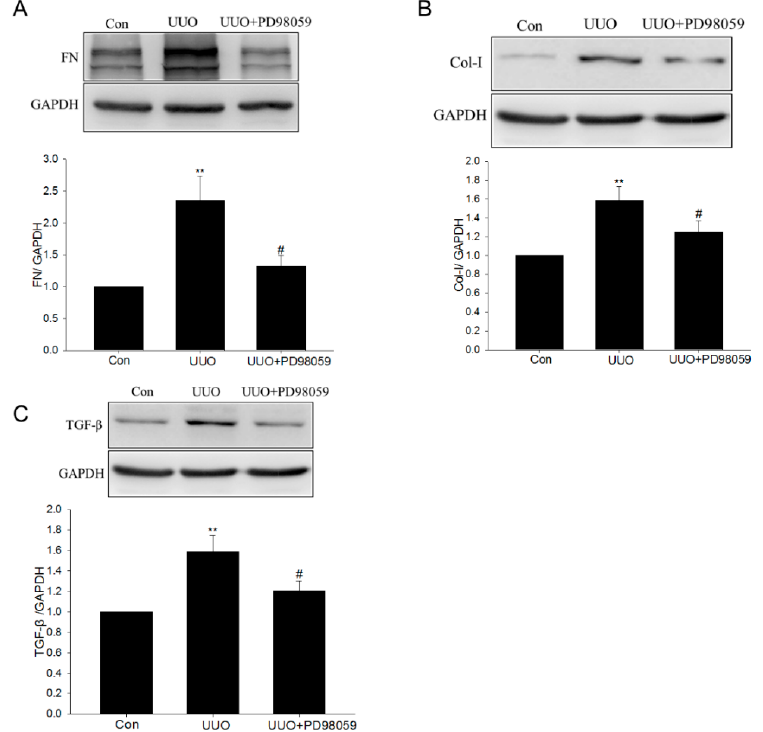
Figure 5. The effect of PD98059 on unilateral ureteral obstruction–induced ECM production and transforming growth factor- β upregulation. ( A – C ) The levels of FN, Col-I and TGF- β were analyzed by Western blotting after PD98059 treatment. Data are the mean ± SEM of four animals. ** p < 0.01 compared with control (Con); # p < 0.01 compared with UUO with vehicle (UUO).